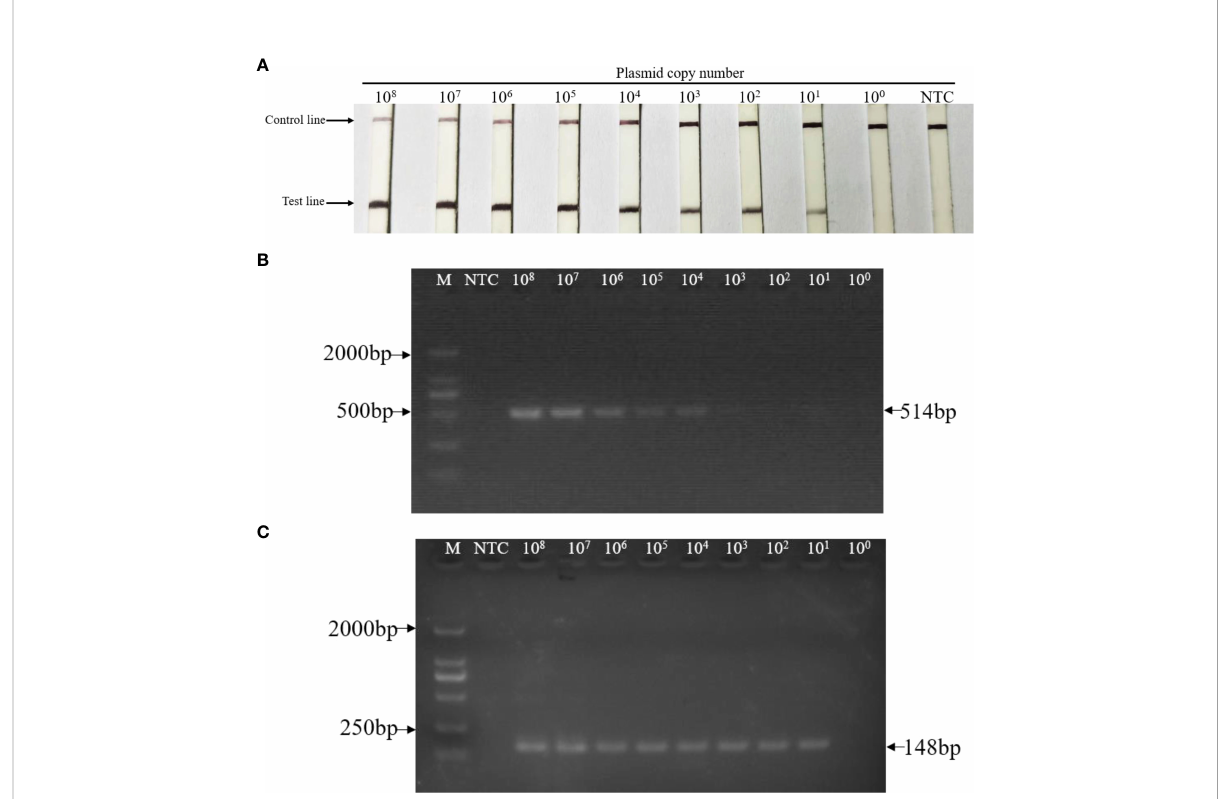
FIGURE 4 Sensitivity of LFD-RPA and nested PCR assay for the detection of EHP. Tenfold serial dilutions of standard plasmid DNA (10 8 copies to 10 0 copies) were tested by (A) LFD-RPA, the fi rst-step PCR reactions (B) , and the nested-step PCR (C) . (A) The sensitivity of the LFD-RPA was ≥ 10 copies of template DNA per reaction. (B) Positive fi rst-step PCR reaction products (514 bp) were detected on a stained agarose gel (2%) when the template DNA was ≥ 10 4 copies per reaction. (C) Positive nested-step PCR reaction products (148 bp) were detected on a stained agarose gel (2%) when the template DNA was ≥ 10 copies per reaction. NTC: no template controls contained water. M: DL2000TM DNA